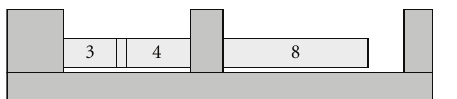
Figure 4: The requests inserted to the holes by the allocation algo- rithm . Notice the overlapping between R (cid:6) 3 and R (cid:6) 4 .